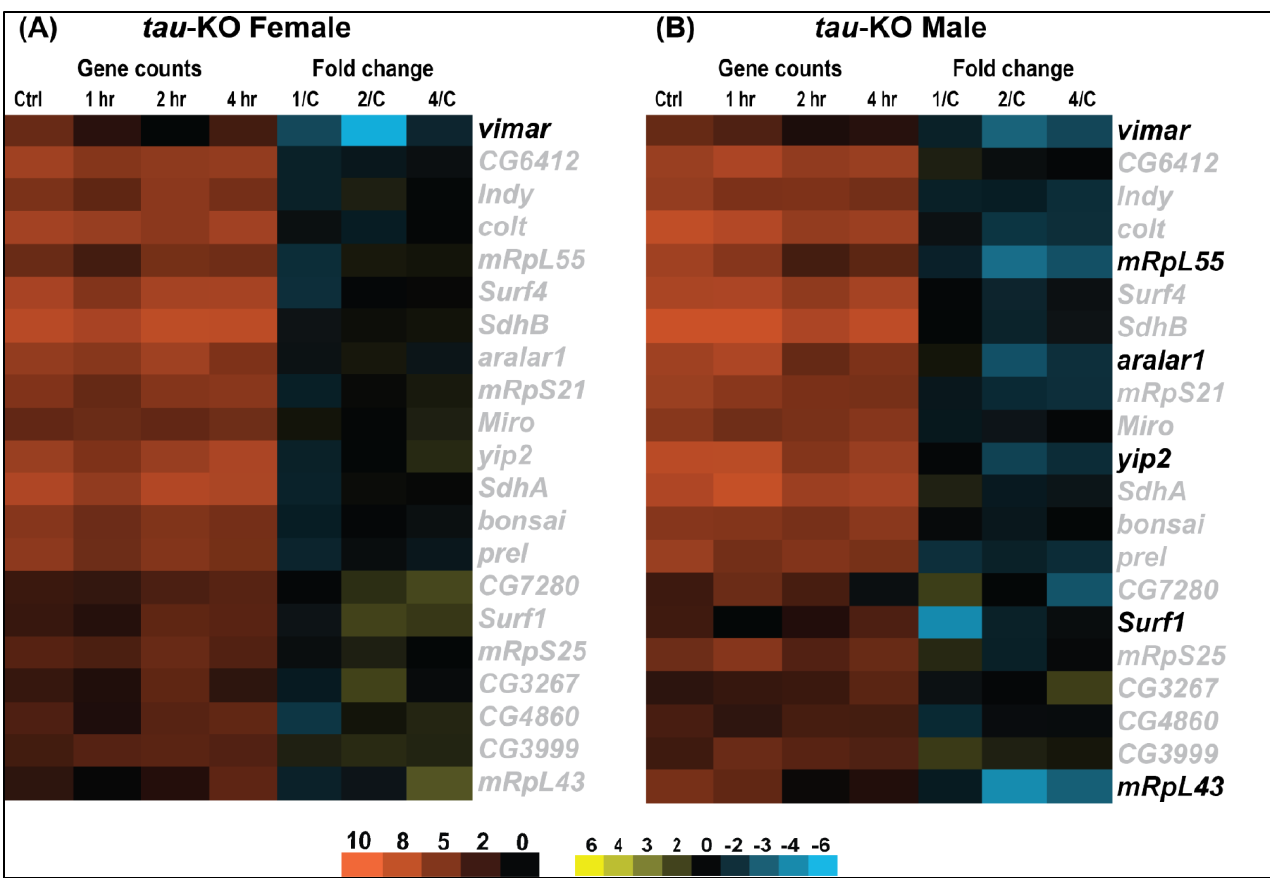
Figure 6. Tau -KO downregulates mitochondrial gene expression changes. Heatmaps depicting mitochondrial gene expression changes in tau -KO females ( A ) and males ( B ) at control, 1, 2 and 4 h after injury. Orange scale represents the average of normalized counts for 3 replicates in each group indicated above (n = 3 for each condition: male and female at control, 1, 2, and 4 h post-TBI). Yellow-blue scale shows fold change for each gene at 1, 2- and 4-h post-injury compared to control. All genes indicated in black font are significant (|log2FC| > 1, p -value < 0.05). 1/C: Fold change at 1 h compared to control; 2/C: Fold change at 2 h compared to control and 4/C: Fold change at 4 h compared to control.